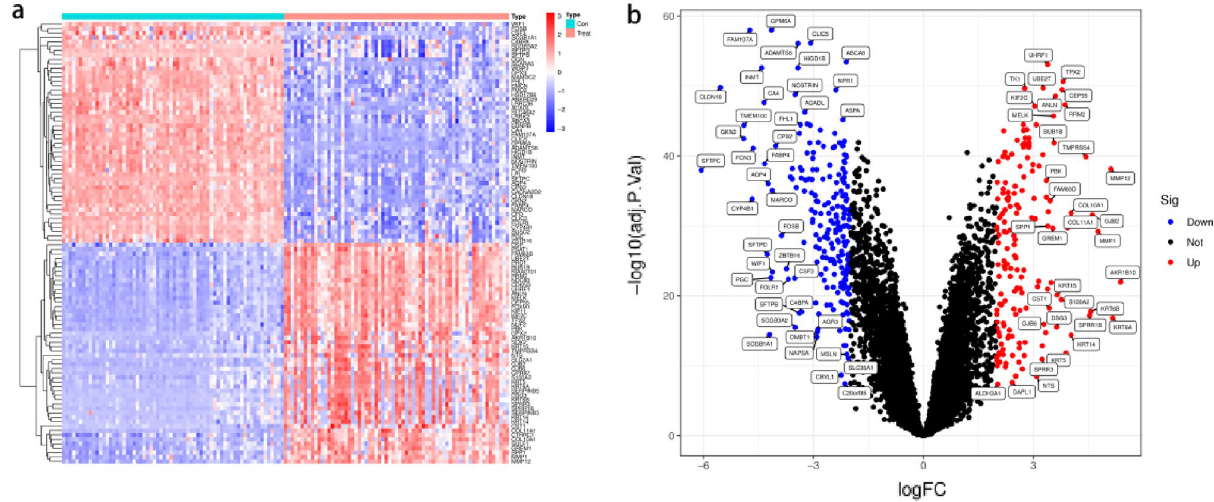
Figure 2. Identification of DEGs. ( a ) Heatmap of DEGs. ( b ) Volcano diagram of DEGs, red indicates up-regulated, blue indicates down-regulated.